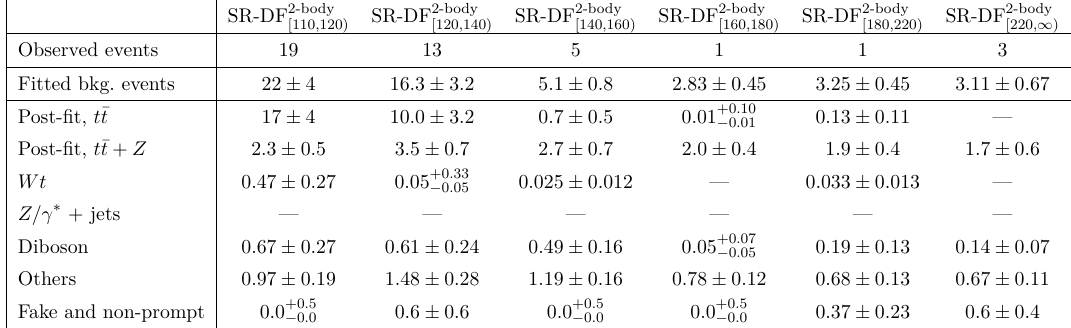
Table 15 . Two-body selection. Background fit results for the different-flavour leptons binned SRs. The ‘Others’ category contains the contributions from V V V , tt t , tttt , tt W , tt WW , tt WZ , tt H , and tZ . Combined statistical and systematic uncertainties are given. Entries marked ‘–’ indicate a negligible background contribution (less than 0.001 events). The individual uncertainties can be correlated, and do not necessarily add up in quadrature to the total background uncertainty.